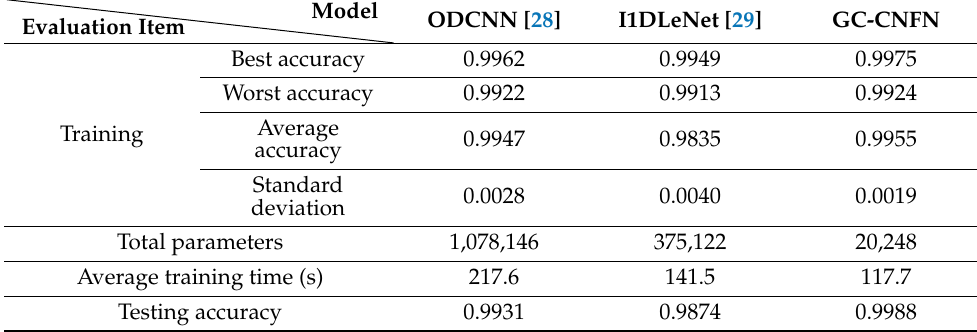
Table 5. Training results of each